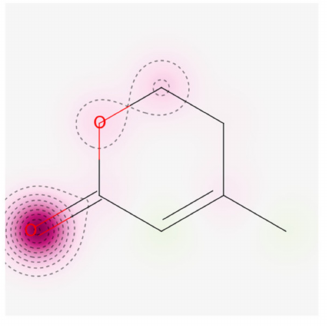
Figure 9. Map of Cardiac toxicity of MVL obtained from pred-hERG.